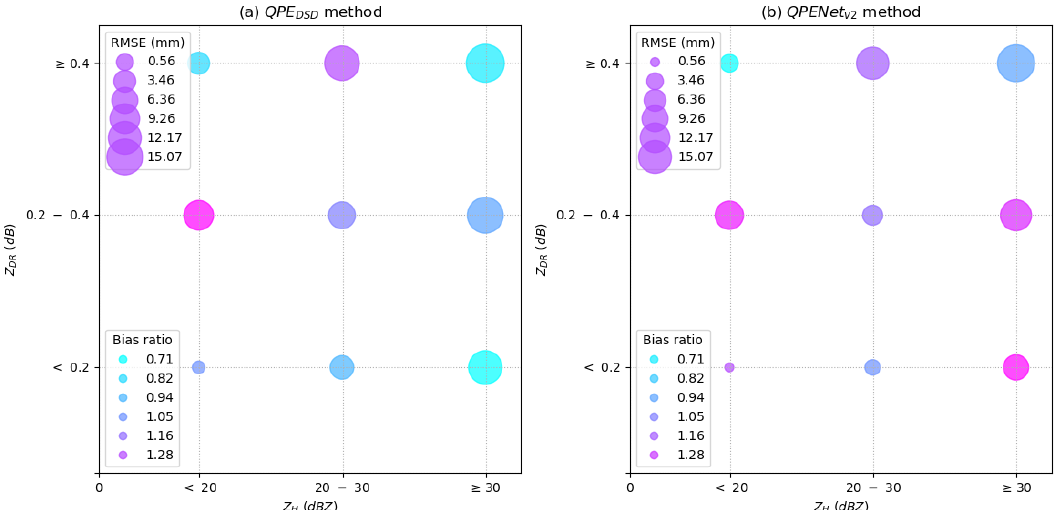
Figure 9. Bubble charts of the bias ratios and RMSEs of the radar-derived hourly rainfall estimates during typhoon Merbok: ( a ) QPE DSD ; ( b ) QPENet V2 . The bias ratios and RMSEs were calculated for different Z H and Z DR ranges using observations from the automatic weather stations as references. Z H is divided into “<20 dBZ”, “20–30 dBZ”, and “ ≥ 30 dBZ”. Z DR is divided into “<0.2 dB”, “0.2–0.4 dB”, and “ ≥ 0.4 dB”. The size of the dots represents the RMSE, the color of the dots indicates the bias ratio.